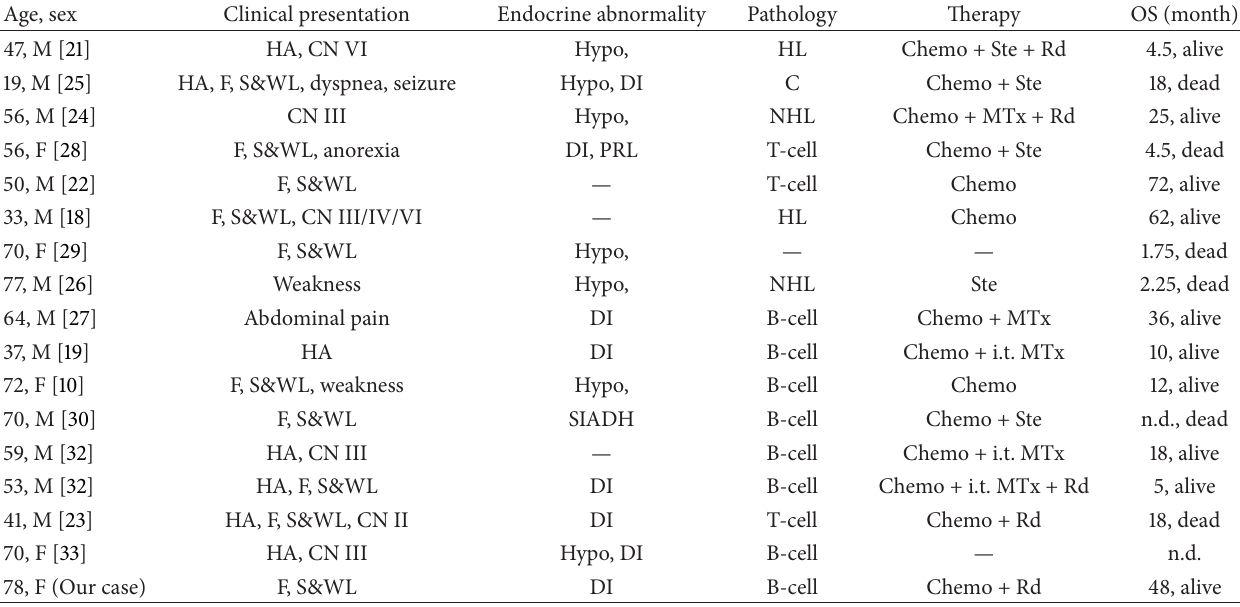
Table 2: Clinical summary of 17 patients with